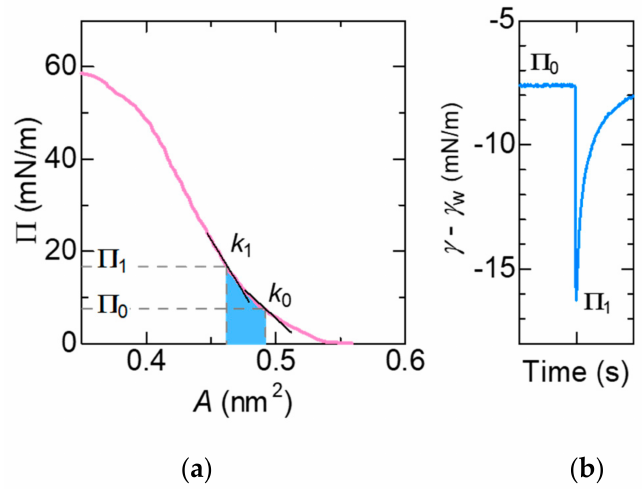
Figure 2. ( a ) Π – A isotherm of DSPC monolayers on the aqueous subphase at 25 ◦ C [15]. The elasticity k 0 and k 1 is calculated directly from the slope at Π 0 and Π 1 , respectively. The elastic energy stored in the lipid monolayer corresponds to the area denoted in blue; ( b ) Oscillation of surface tension. See the definition of Π 0 and Π 1